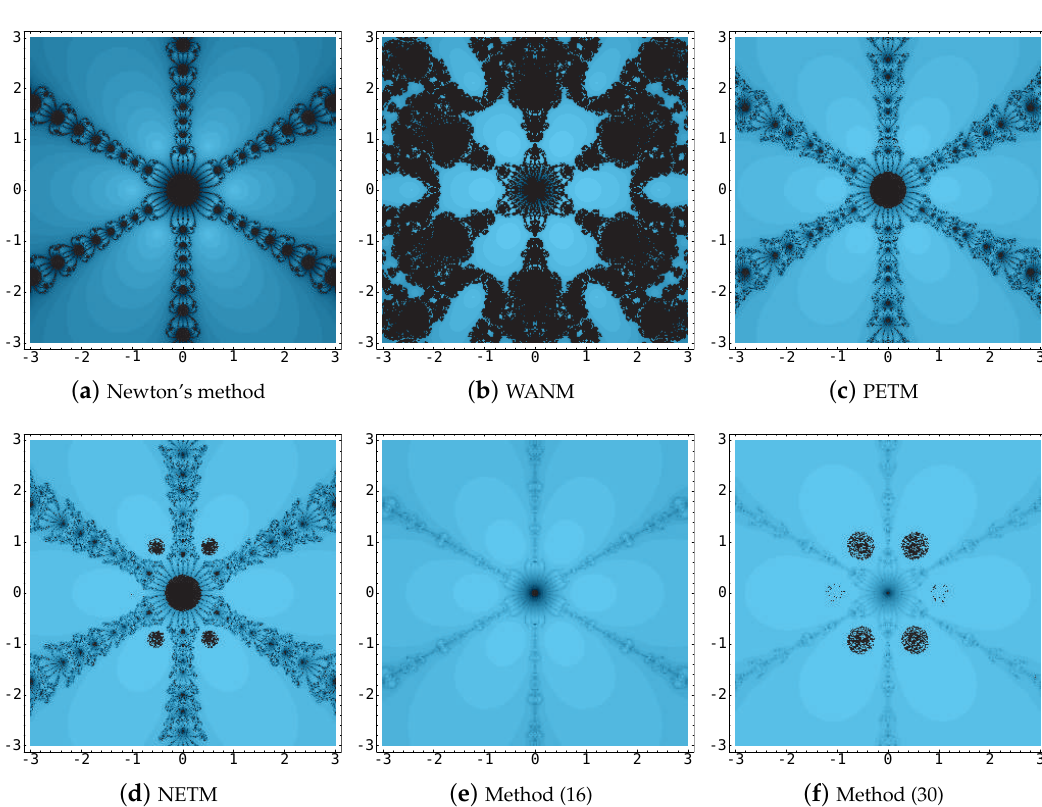
Figure 5. The results are for the polynomial z 6 −